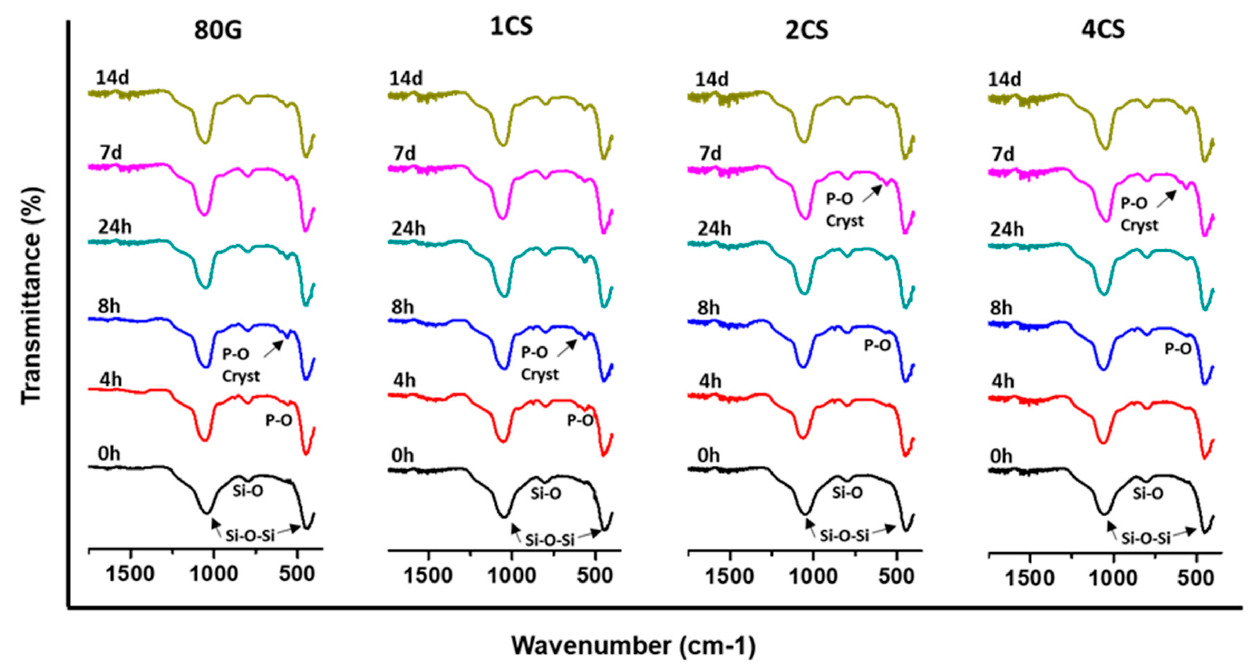
Figure 7. FTIR spectra of all MBG powders before and after 0 h, 4 h, 8 h, 24 h, 7 d and 14 d of immersion in SBF.